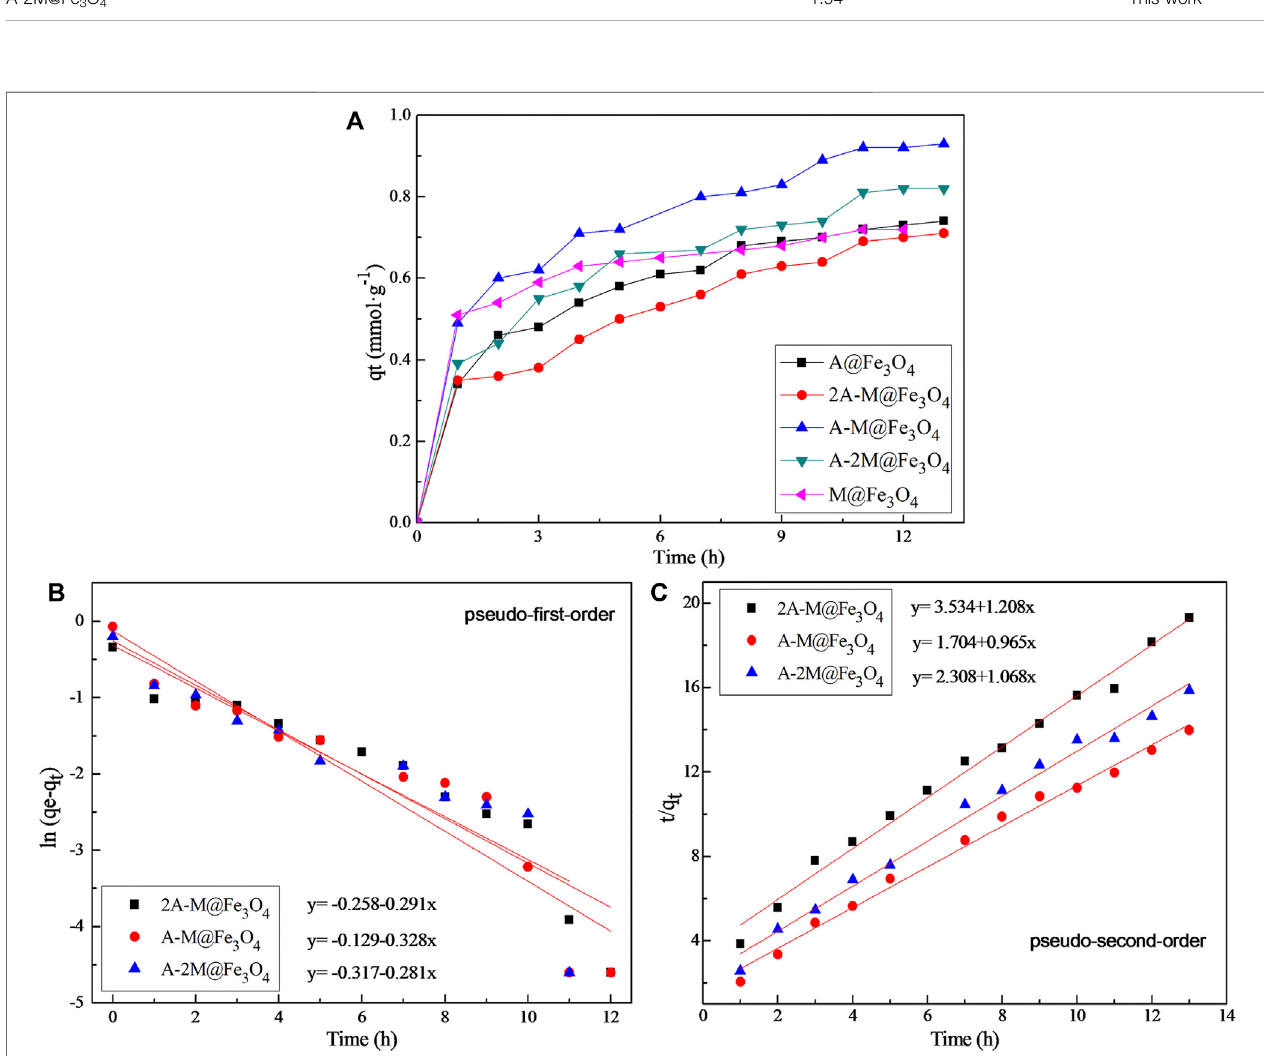
FIGURE 4 | (A) The adsorption kinetic curves of PSQ/CNTs magnetic composites for Hg(II) at pH 4.5 and 25 ° C; (B) the pseudo- fi rst-order and (C) the pseudo- second-order adsorption models of bifunctional PSQ/CNTs magnetic composites for Hg(II).